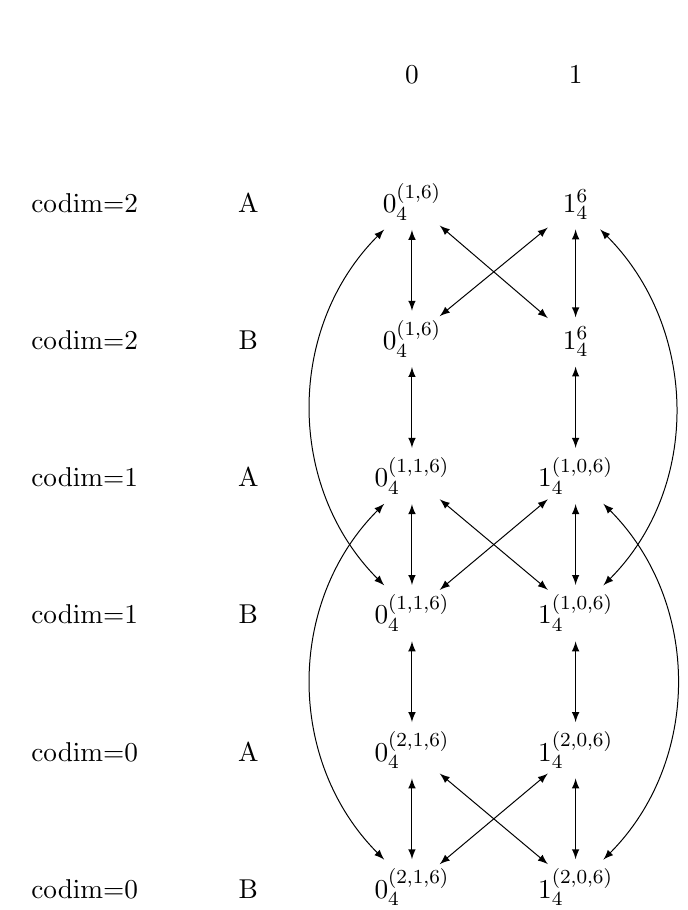
Figure 6 . The T-duality orbit of the 1 6